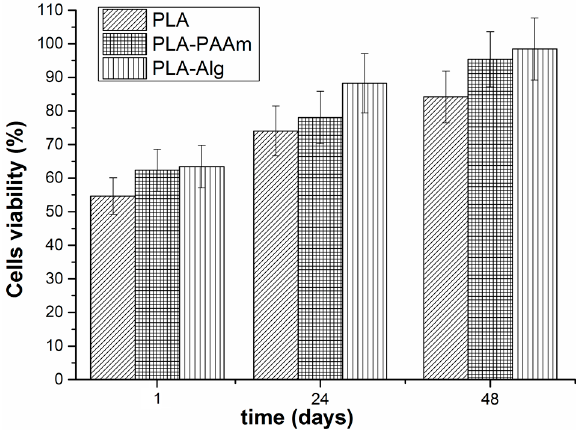
Figure 12. 3-(4,5-dimethylthiazol-2-yl)-2,5-diphenyltetrazolium bromide (MTT) assay: cell viability on